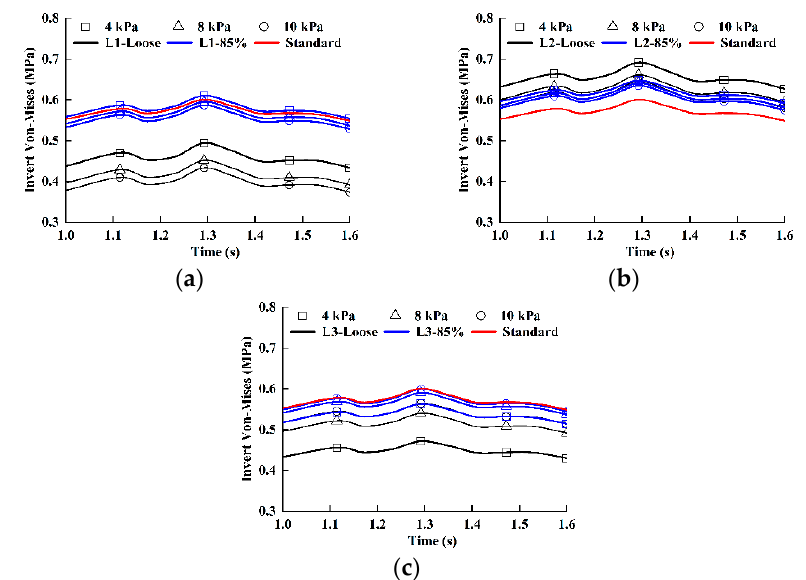
Figure 19. The invert Von-Mises stresses of pipes of different hoop stiffness under traffic load: ( a ) change in L1 compaction degree; ( b ) change in L2 compaction degree; ( c ) change in L3 compaction degree.